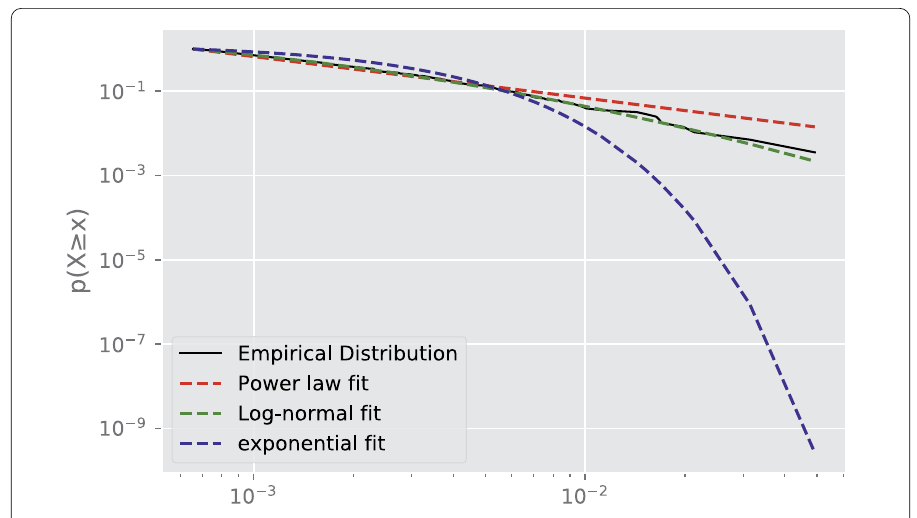
Figure 9 Comparison of power-law distribution and exponential distribution fit on the empirical distribution